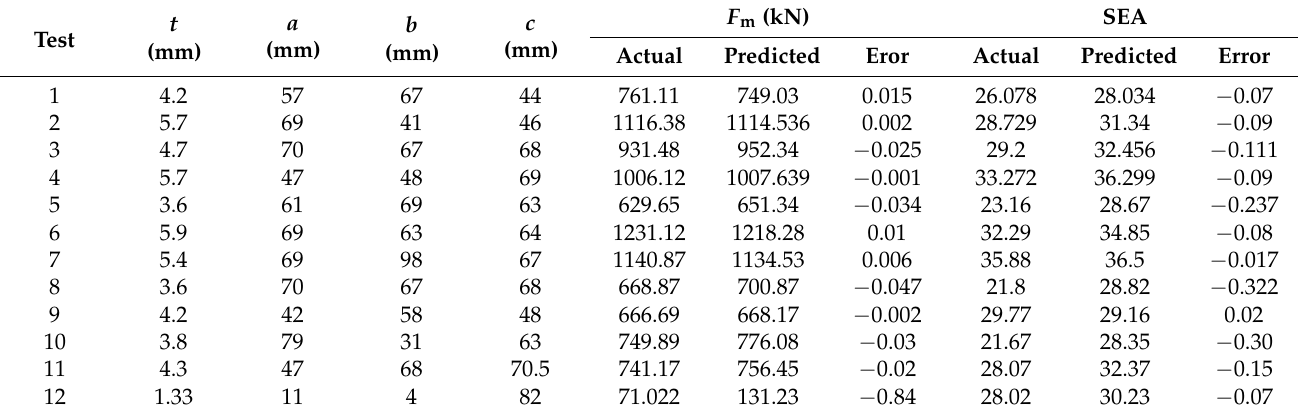
Table 3. Comparison response